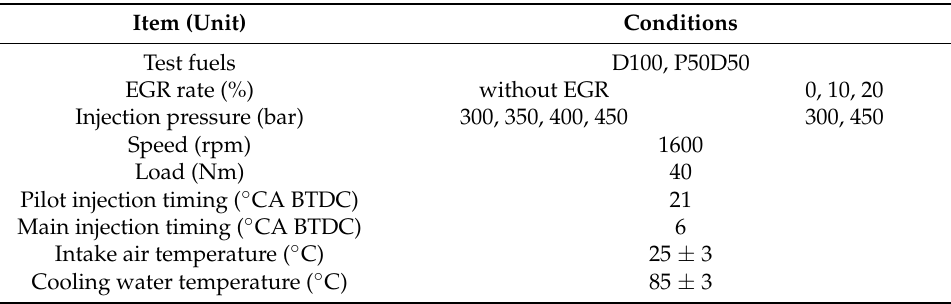
Table 3. Test and operating conditions.